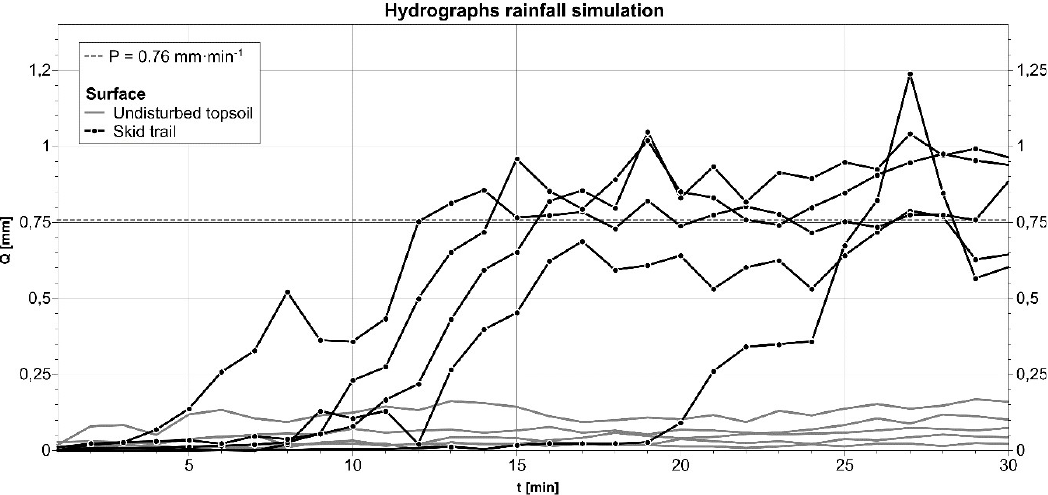
Figure 7. Hydrographs for rainfall simulations conducted; surface categories and constant precipitation input are